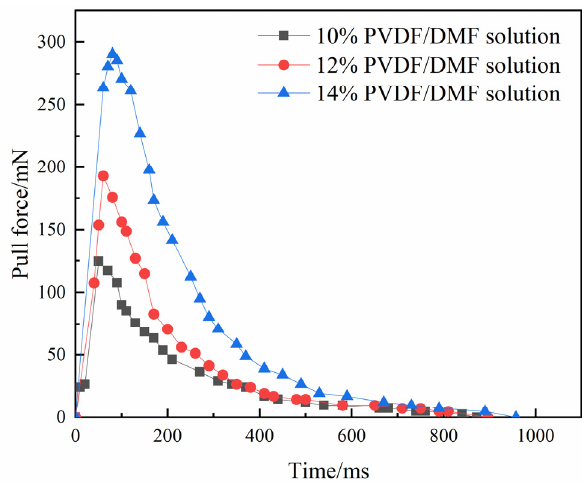
Figure 4. Pull force versus stretching time.